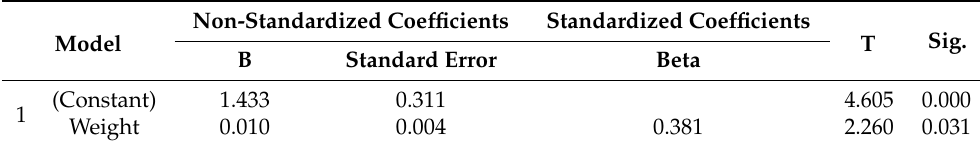
Table 6. Coefficients and dependent variable: